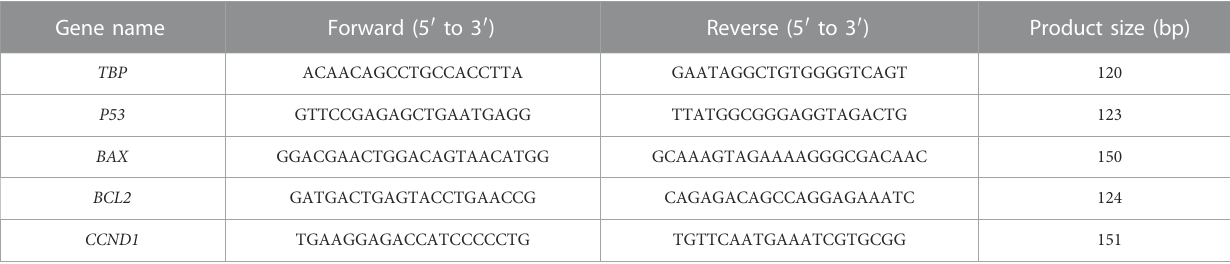
TABLE 1 List of primers, their sequence, and product length used in the present